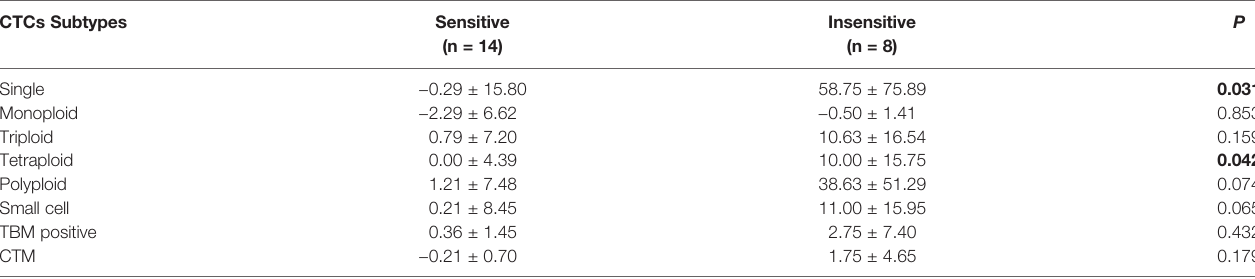
TABLE 2 | CTC subtypes and dynamics in bladder-cancer patients with neoadjuvant chemotherapy. CTCs Subtypes